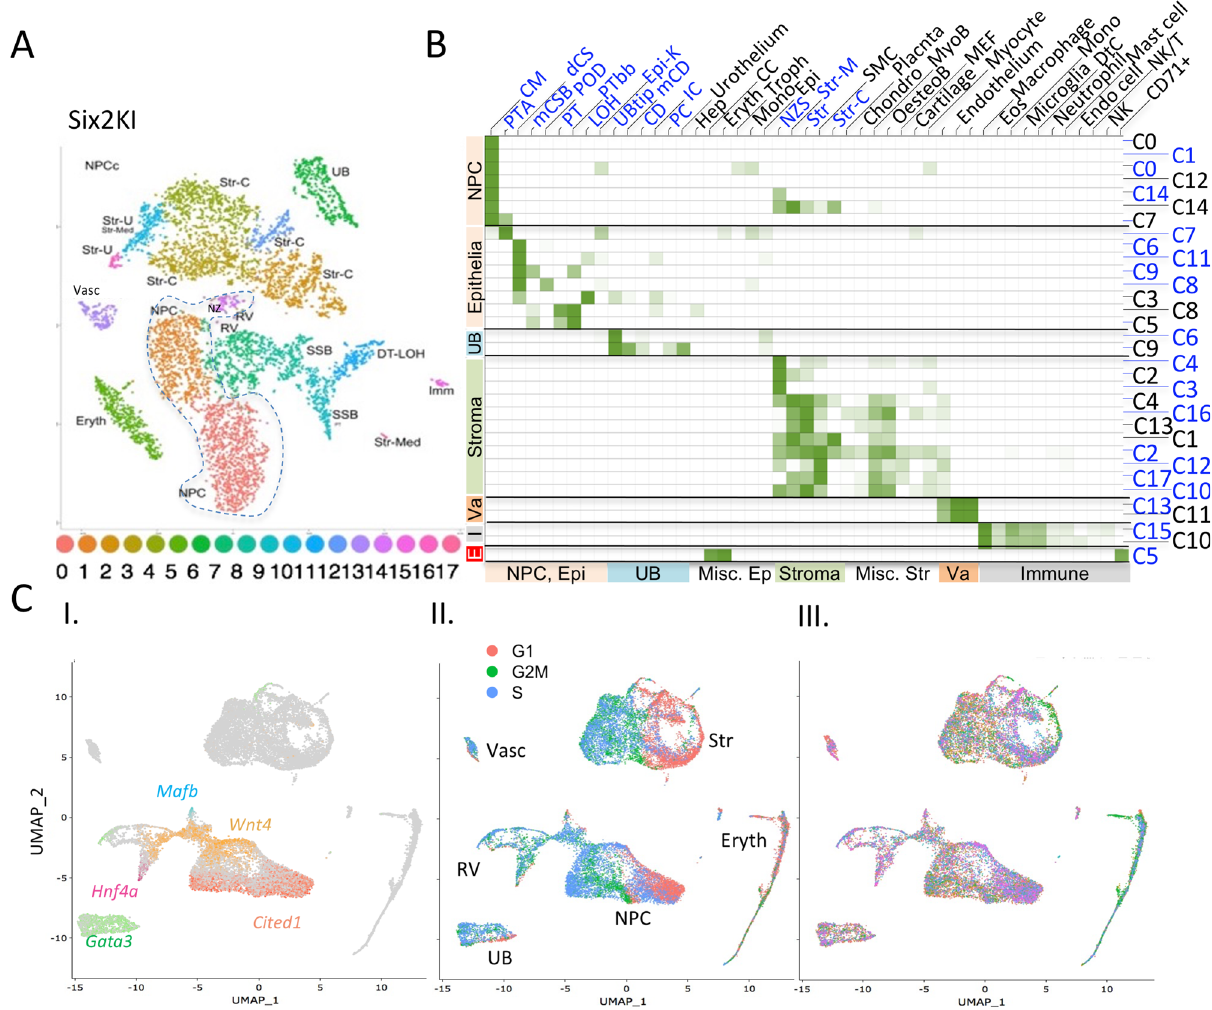
Fig. 1 Cell populations identi fi ed in developing kidneys with different genetic makeup are indistinguishable. A tSNE of E14 Six2 KI data identi fi es 18 clusters. Annotation of clusters based on similarity to kidneys of the same genotype analyzed by Combes et al. 49 B GO-Elite analysis of Combes ’ (black, C0-C14) and our (blue, C0-C17) Six2 KI clusters against global datasets. Note the cortical bias in our clusters. C UMAP clustering of all six samples. Gene expression patterns were merged in photoshop (i) to illustrate the temporal progression from naive ( Cited1 + , right) to epithelial ( Gata3 + , Hnf4a + , Mafb + ) at left. Wnt4 marks transitional primed NPC. Cell-cycle states and cell type identities are shown in (ii), and the genotype contribution to each super-cluster in (iii). Note that contaminating erythrocytes are contributed predominantly by the green sample, E14 Six2 TGC;Tsc1 (color key in Fig.